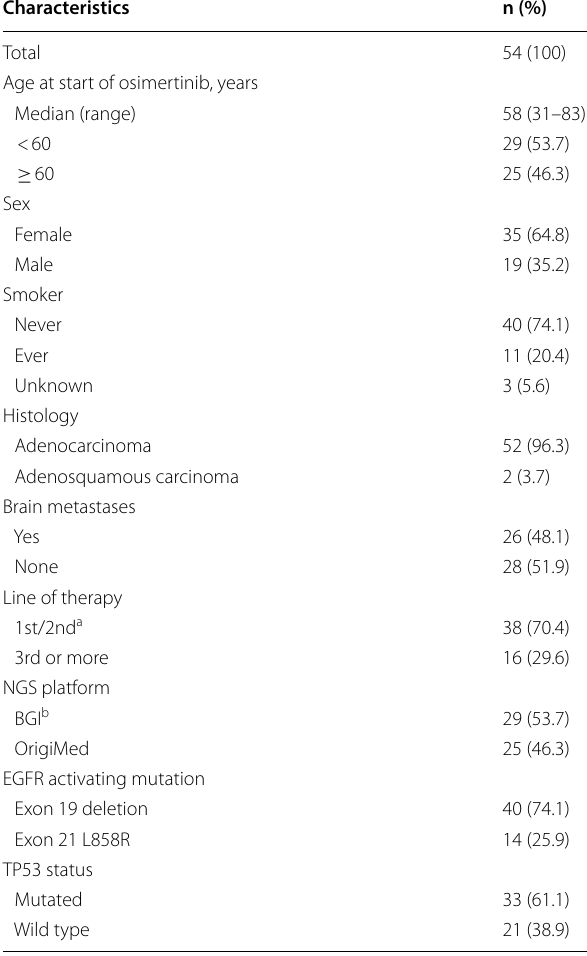
Table 1 Characteristics of included patients in our